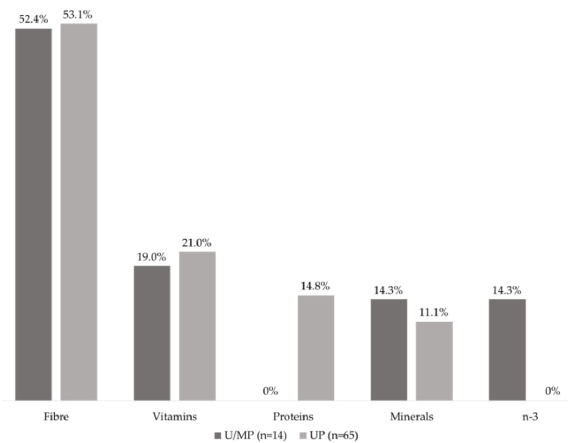
Figure 2. Distribution of Complementary Nutritional Information about ‘increased content’ or ‘presence’ of different nutrients in the analysed products. Legend: U/MP = Unprocessed/Minimally Processed foods. UP = Ultra-processed foods.